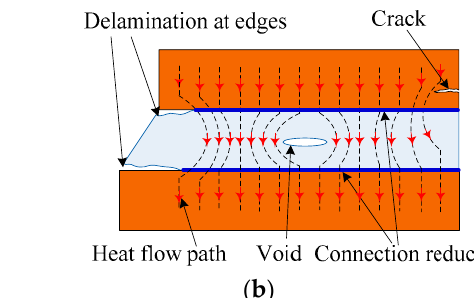
Figure 1. Cross-sectional view of base-plate free insulated gate bipolar transistor (IGBT) module with a heat-sink: ( a ) Aluminum metallization, ( b ) Chip, ( c ) Bond wire, ( d ) Copper pad, ( e ) Solder, ( f ) Ceramic subtracts, ( g ) Thermal grease, and ( h ) Heat-sink.